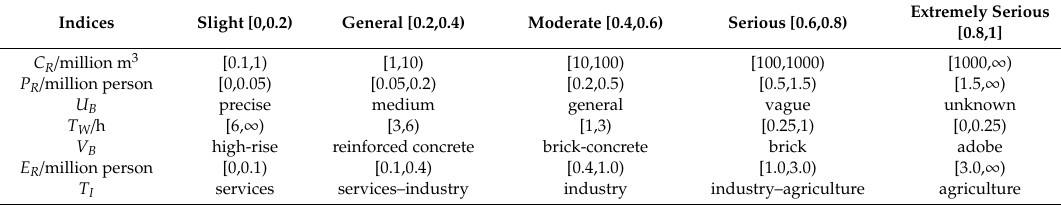
Table 3. Corresponding grades of relevant indices.